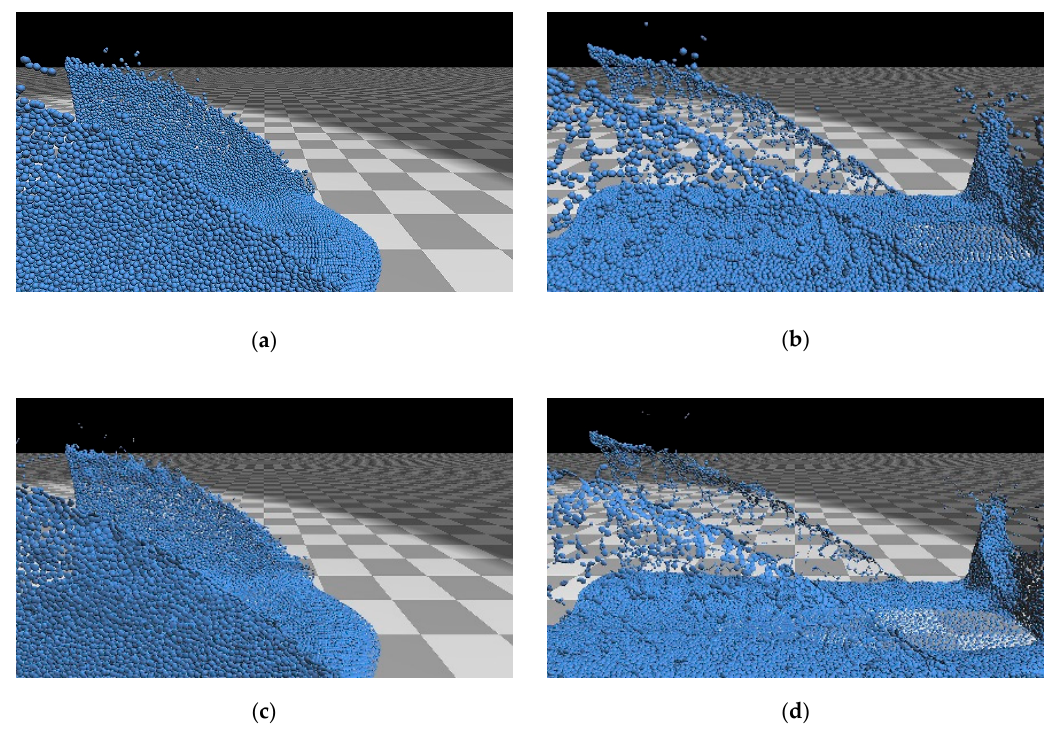
Figure 15. The rendering results of the improved method from different time steps of the experimental dam break scene: ( a , b ) the isotropic particle rendering results; and ( c , d ) the improved anisotropic particle rendering results. Obviously, in the edge region, the images in ( c , d ) have sharp features.